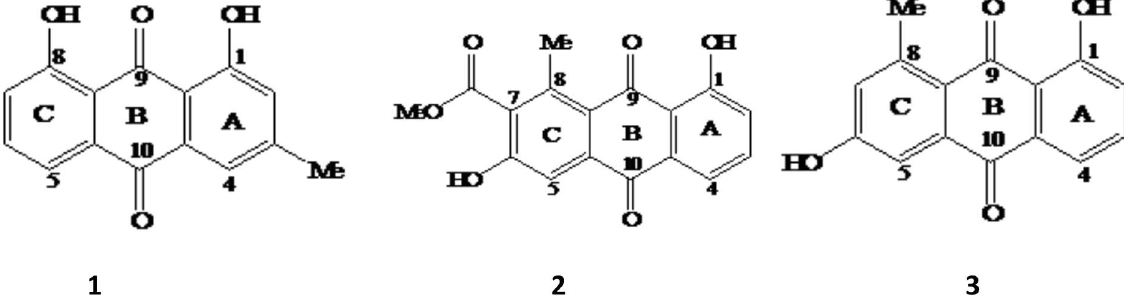
Fig 1. The structures of chrysophanol (1), aloesaponarin I (2) and aloesaponarin II (3) isolatedfrom root of A . pulcherrima . https://doi.org/10.1371/journal.pone.0173882.g001 showed five aromatic and three methyl protons. Three mutually coupled aromatic protons at 7.70 ( d , J = 7.6 Hz), 7.80 ( t , J = 7.8 Hz) and 7.37 ( d , J = 8.2 Hz) with ABX spin system were δ H assigned to H-5, H-6 and H-7 of mono-substituted ring C of a 1,8-dihydroxyanthraquinone, respectively. The presence of two meta -coupled aromatic protons resonating at δ 7.21 ( d , H J = 2.4 Hz) and 7.55 ( d , J = 2.4 Hz) assigned to H-2 and H-4, respectively, with the biosyntheti- cally expected aromatic methyl ( δ 2.46) group being at C-3 of the di-substituted ring A. The H 1 H NMR data, therefore, suggested that compound 1 is 1,8-dihydroxy-3-methyl anthraqui- none. In consistency with the aforementioned spectral data, the 13 C NMR spectrum revealed 15 carbon signals; five aromatic methines ( δ 123.6, 122.4, 127.3, 127.6 and 140.4), seven aro- C matic quaternary carbons ( δ 116.9, 119.0, 136.2, 136.4, 152.2, 164.6 and 164.8), two carbonyl C carbons ( δ 194.4 and 184.6) and a methyl ( δ 24.7) group. Based on these and comparison C C